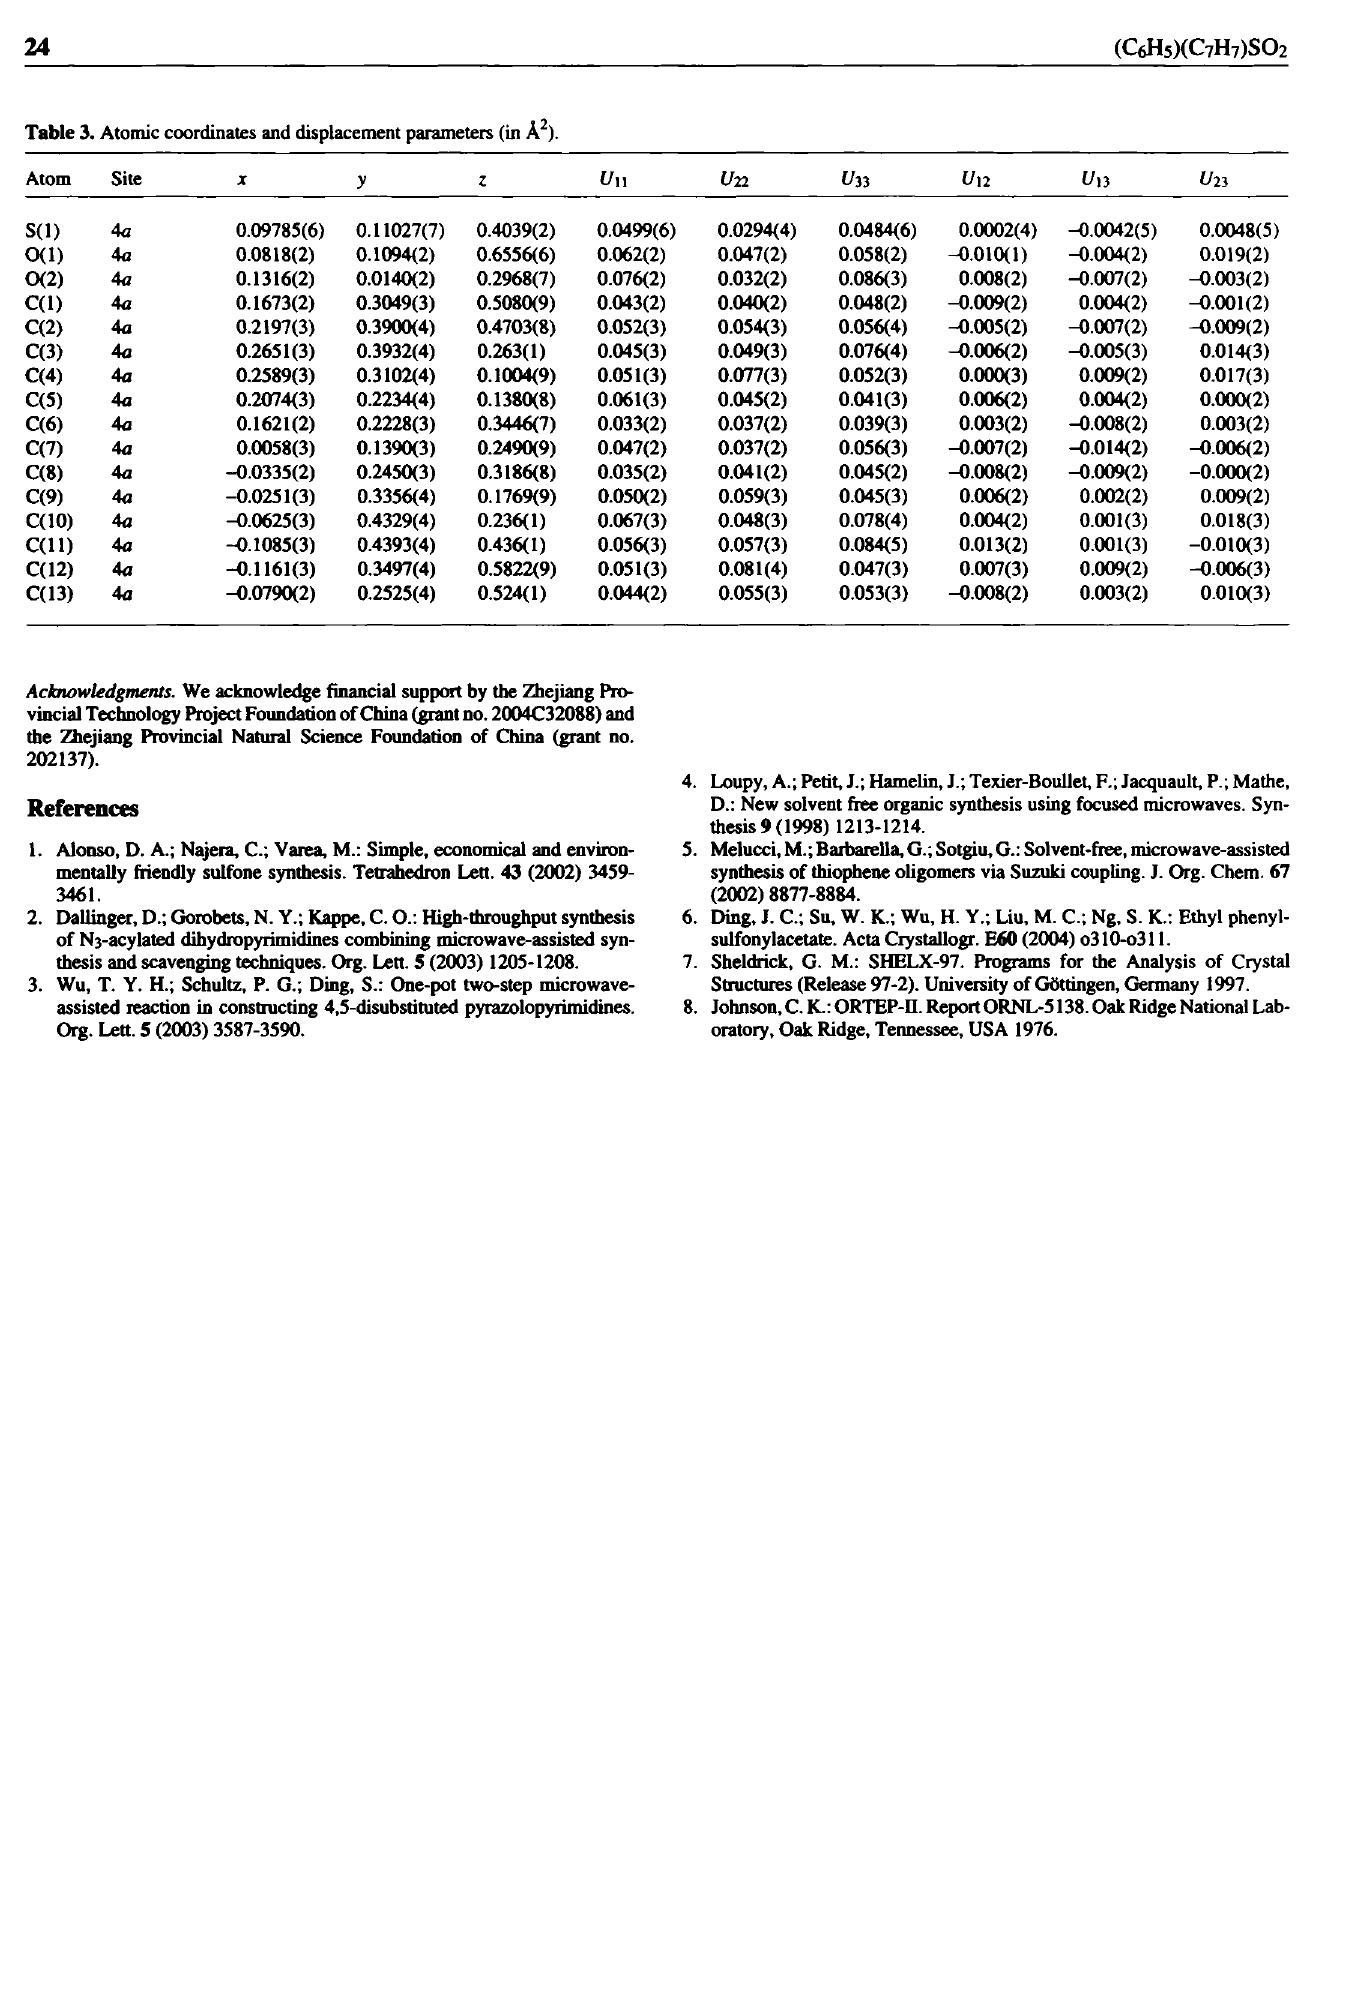
Table 3. Atomic coordinates and displacement parameters (in A 2